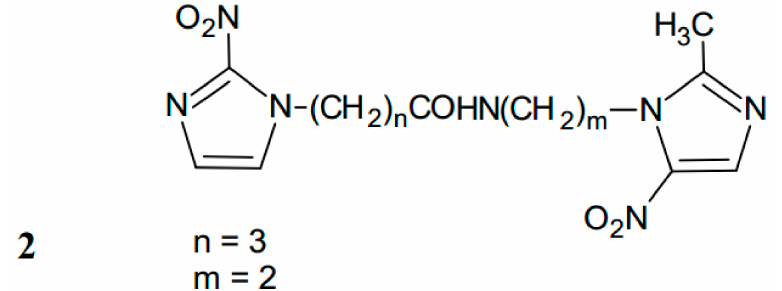
Figure 2. The structure of carboxamide-linker